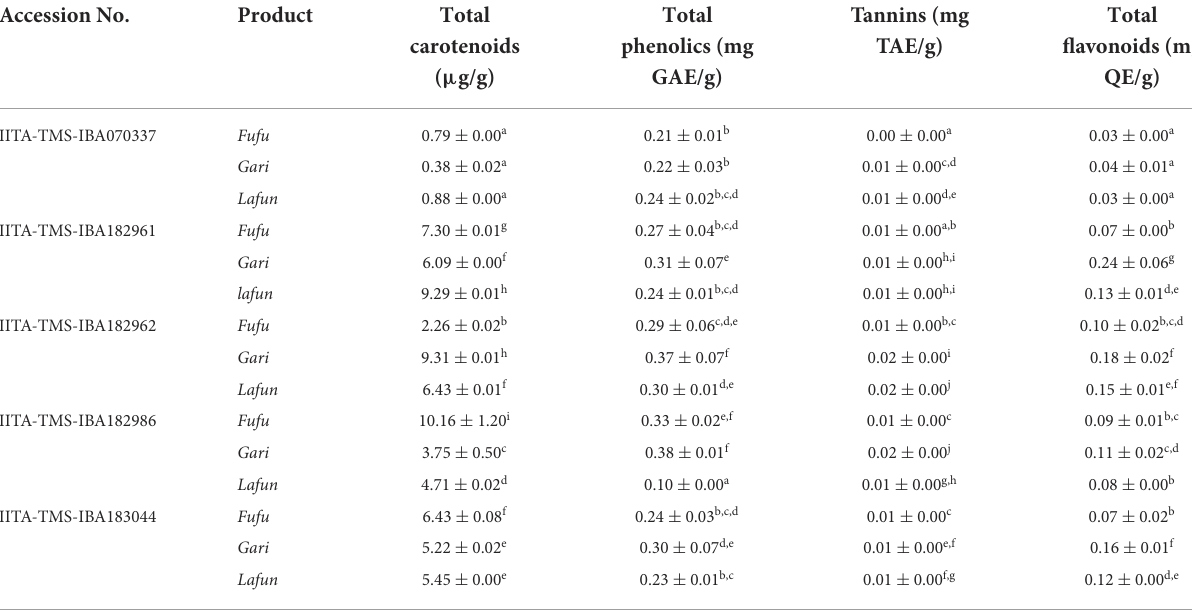
TABLE 1 Bioactive constituents of fufu, lafun and gari from five provitamin A biofortified yellow-fleshed cassava genotypes. Accession